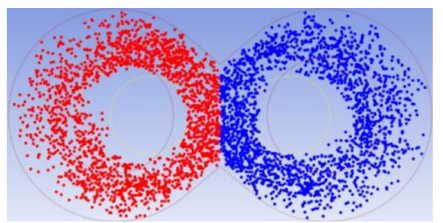
Figure 15. Initial particle distribution.